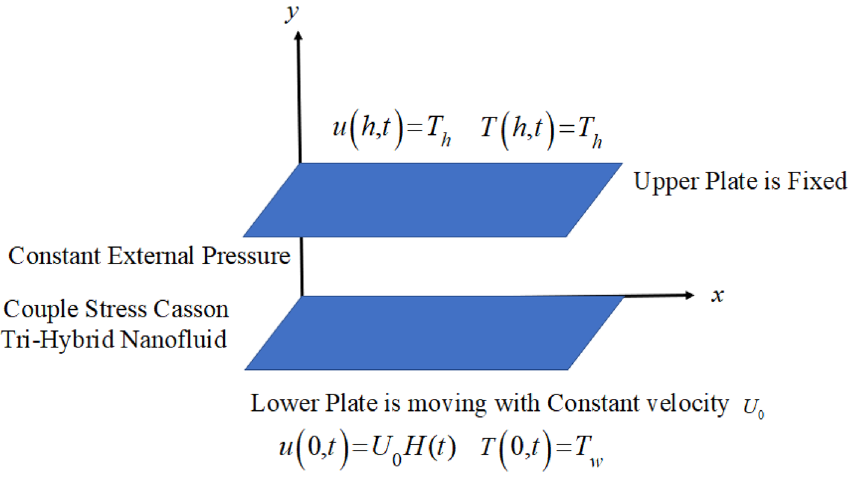
Figure 1. Geometry of the